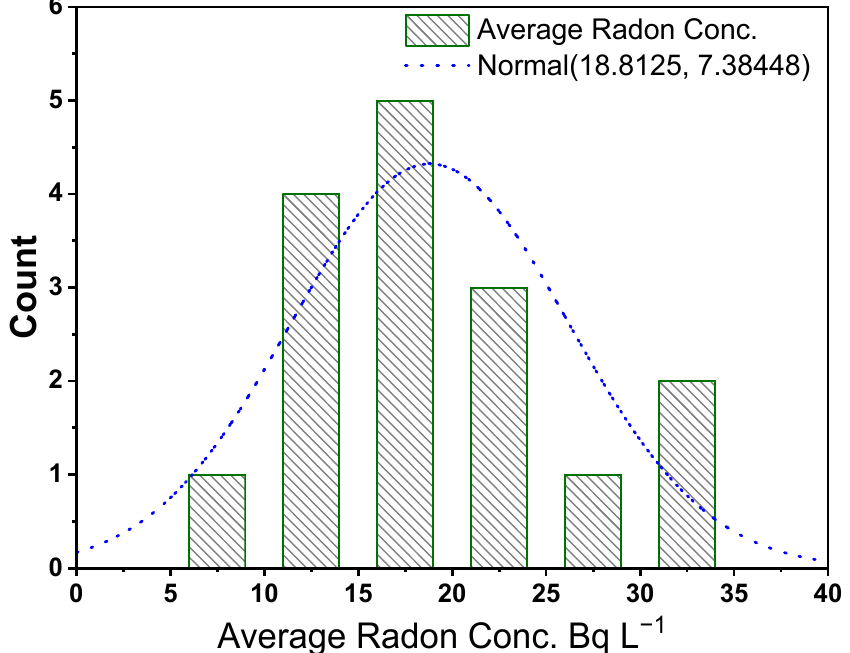
Figure 4. Normal distribution histogram of the measured radon activity concentrations for the sixteen samples.